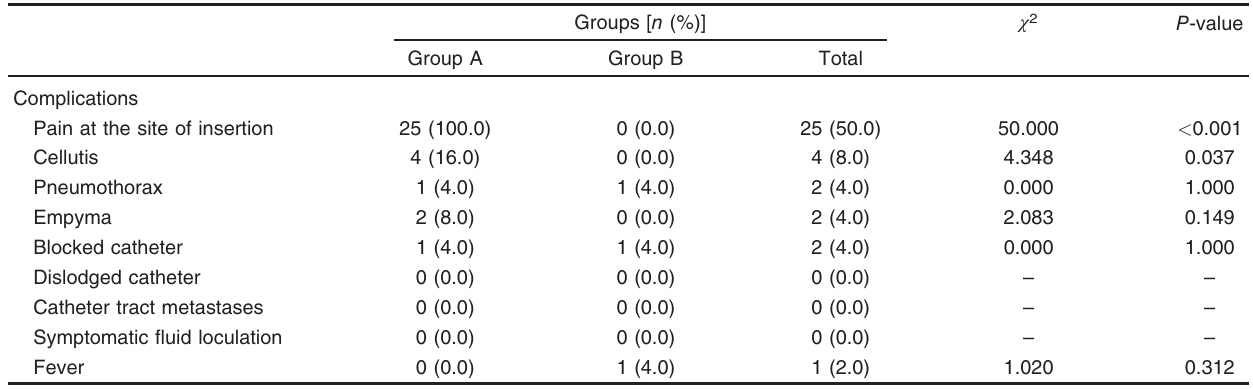
Table 6 Summary of adverse events among groups A and B at baseline